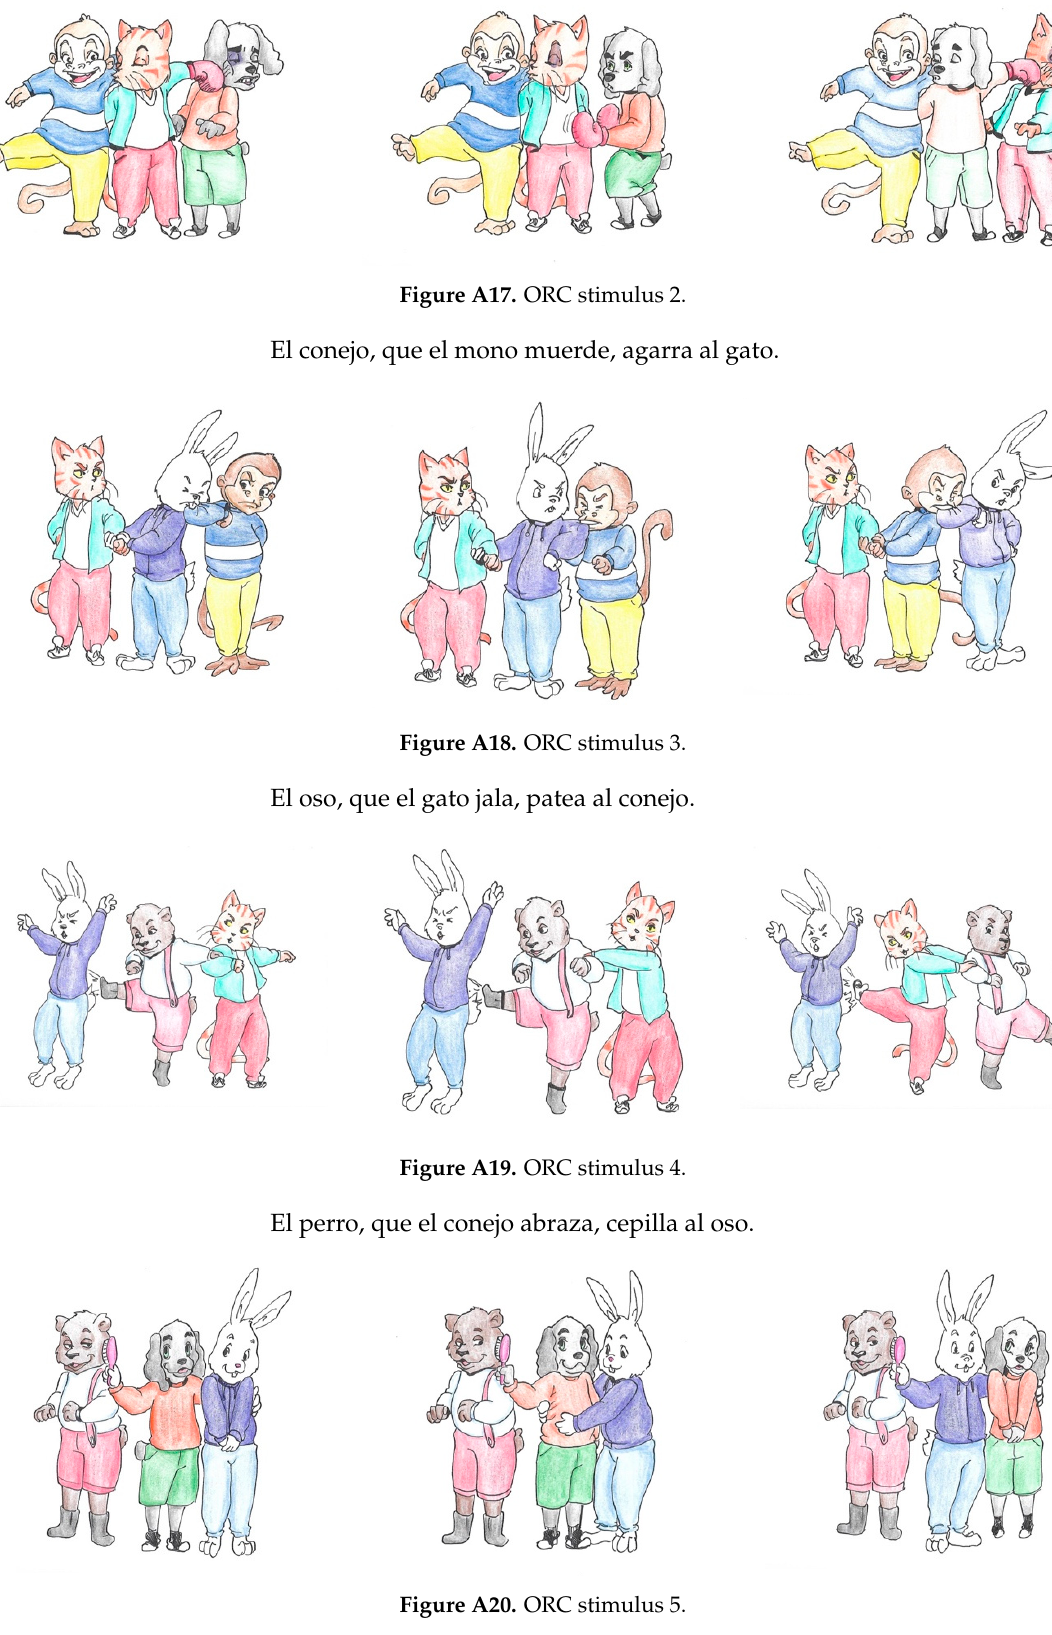
Figure A16. ORC stimulus 1.